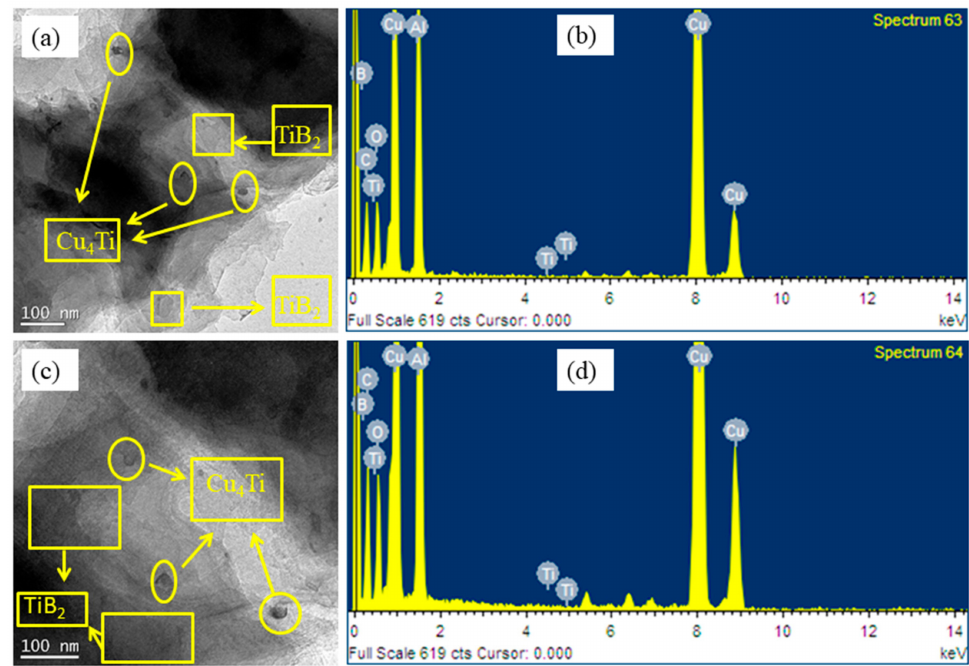
Figure 7. TEM of two types of the composite after heat treatment: ( a ) for Cu-2B-4Ti and ( c ) for Cu-5B 10Ti; ( b , d ) denotes their EDX, respectively.